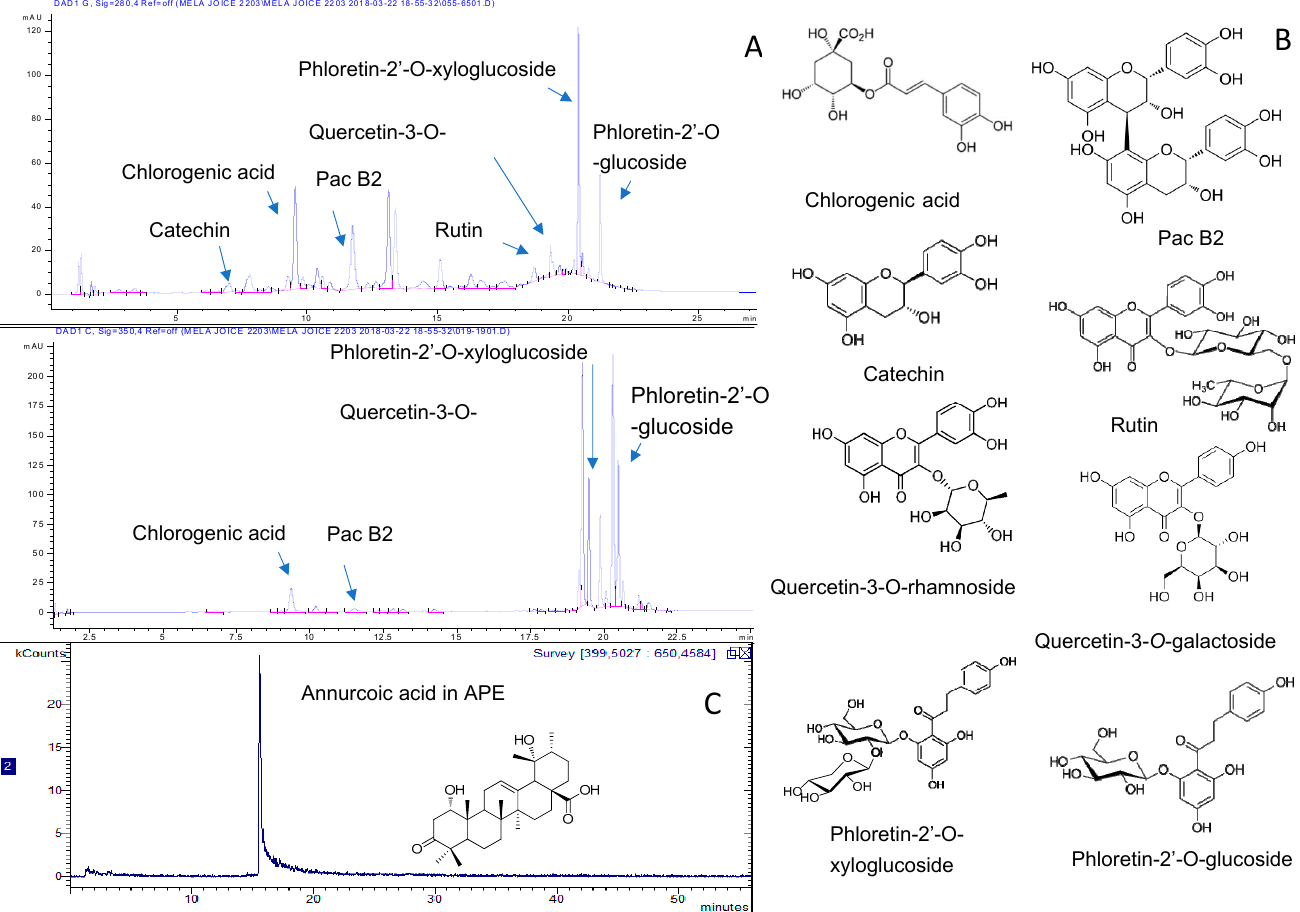
Figure 1. HPLC (High performance liquid chromatography) chromatogram of apple pulp (APP) at 254 nm ( A ), with chemical structures of the main constituents ( B ). LC-APCI-MS (liquid chromatography atmospheric pressure chemical ionization mass spectrometry) chromatogram of apple peel (APE) extract showing a peak related to annurcoic acid ( C